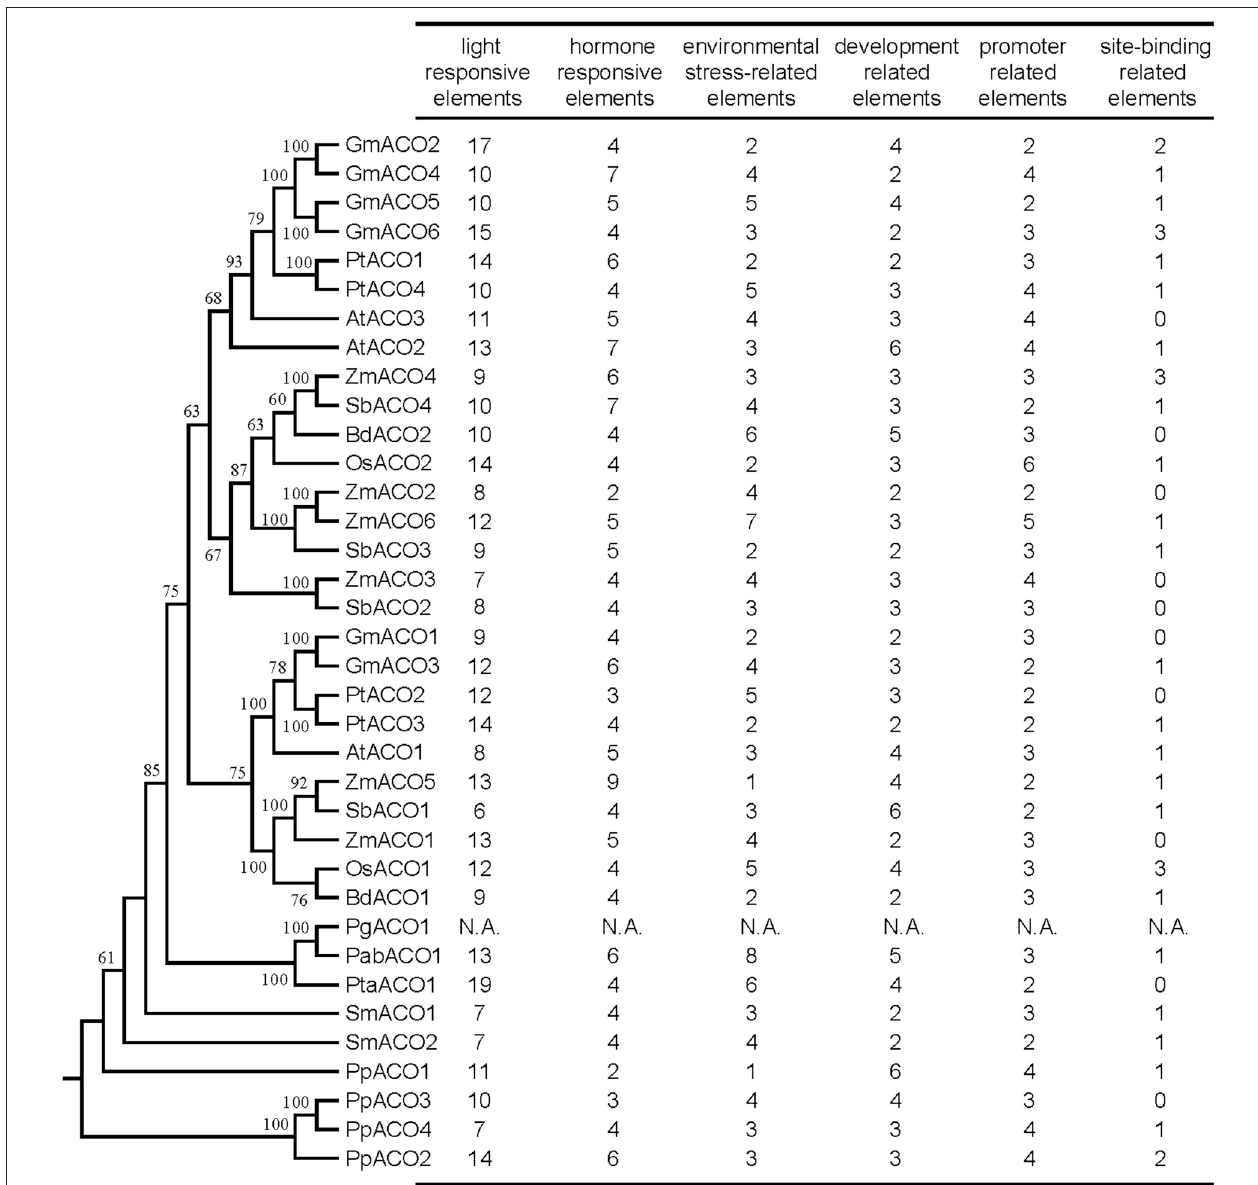
FIGURE 9 | Number of variations of cis -acting elements in the promoter region of the ACO gene in land plants. All cis -acting elements were divided into six categories according to their function. N.A. indicates that data are not available.